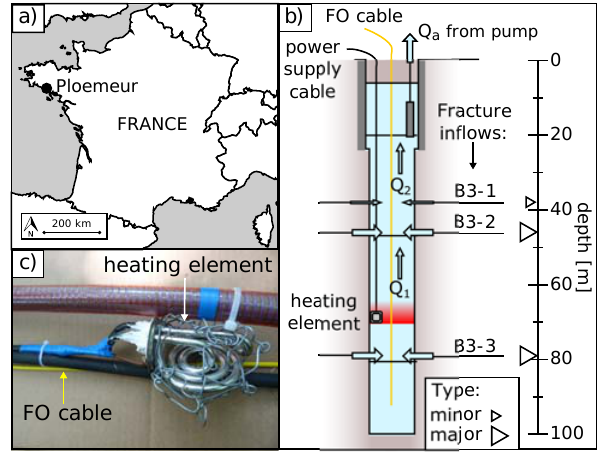
Figure 1. (a) Location of the Ploemeur research site; (b) heating element and fibre optic cable along which temperature is measured; (c) schematic of the set-up in borehole B3 at the